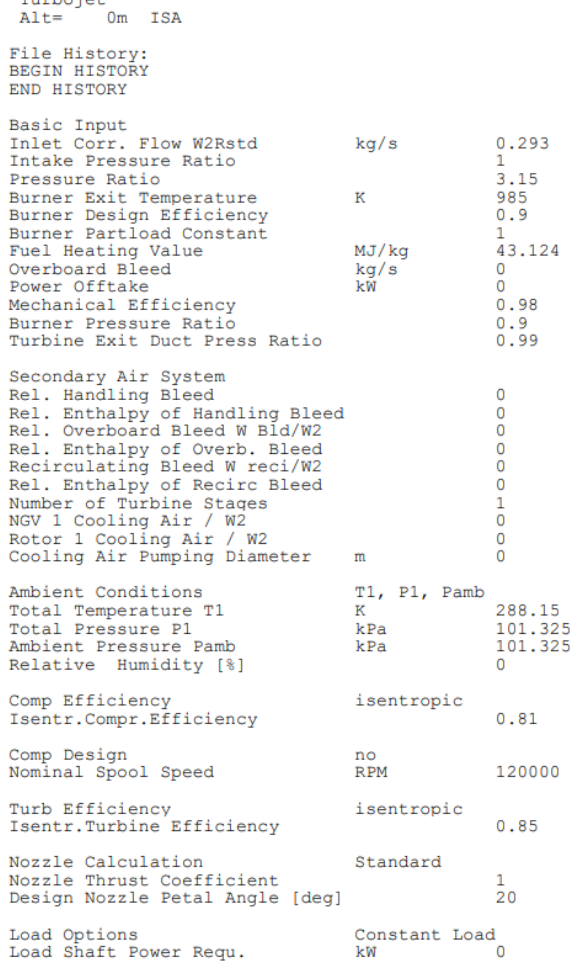
Figure A1. Baseline BMT 120 KS Turbojet input parameters to GasTurb 13 Software.